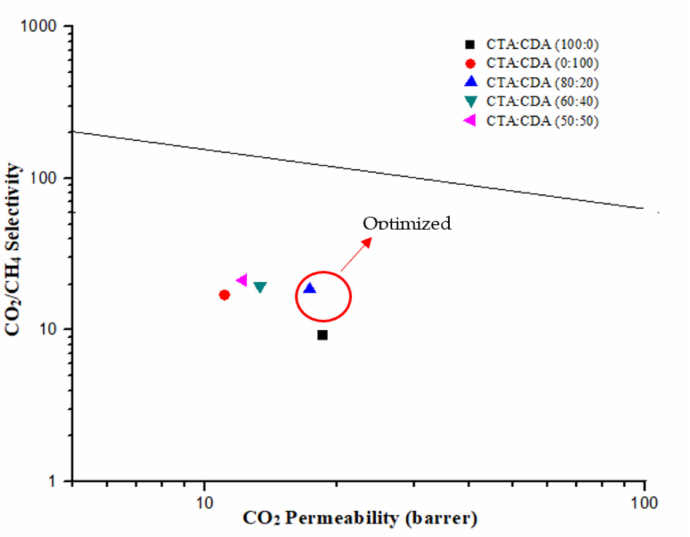
Figure 7. Performance comparison of fabricated membranes on Robeson’s upper bound